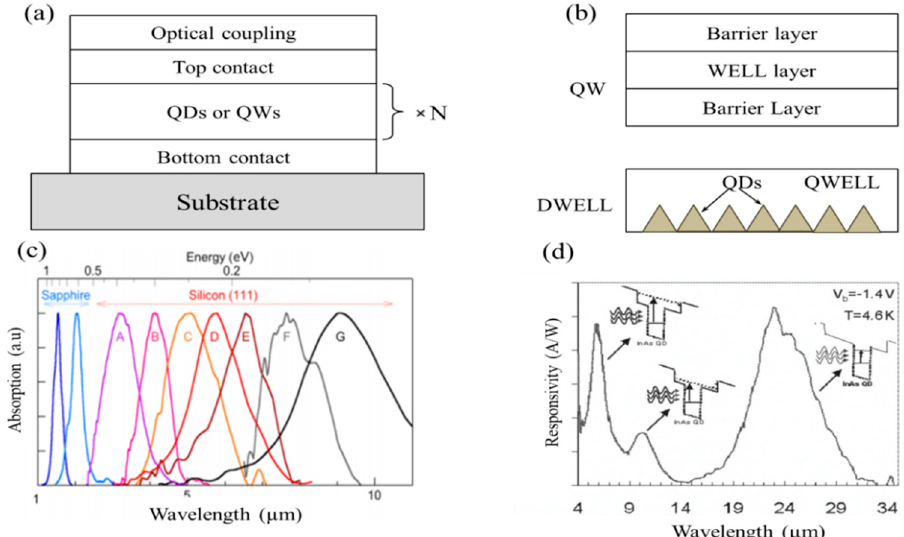
Figure 2. ( a ) Schematic of QW or QD layers with optical coupling layer and ( b ) structures of sandwiched QWs with multiple barrier layers and dot-in-well (QWELL) structure, indicated below ( c ) The tunable absorption in GaN/AlGaN QWs is shown by adjusting the width of the GaN QW layer (reproduced with the permission of Reference [49], Copyright 2009, IOP Publishing). Moreover, ( d ) shows the multiple band spectral response in a InAs/InGaAs/GaAs dot-in-well structure, (Reproduced with the permission of Reference [50]. Copyright 2007, IEEE).